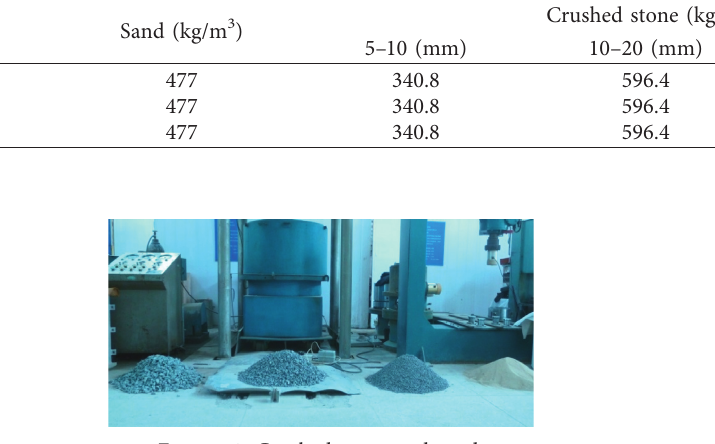
Figure 1: Crushed stone and sand.